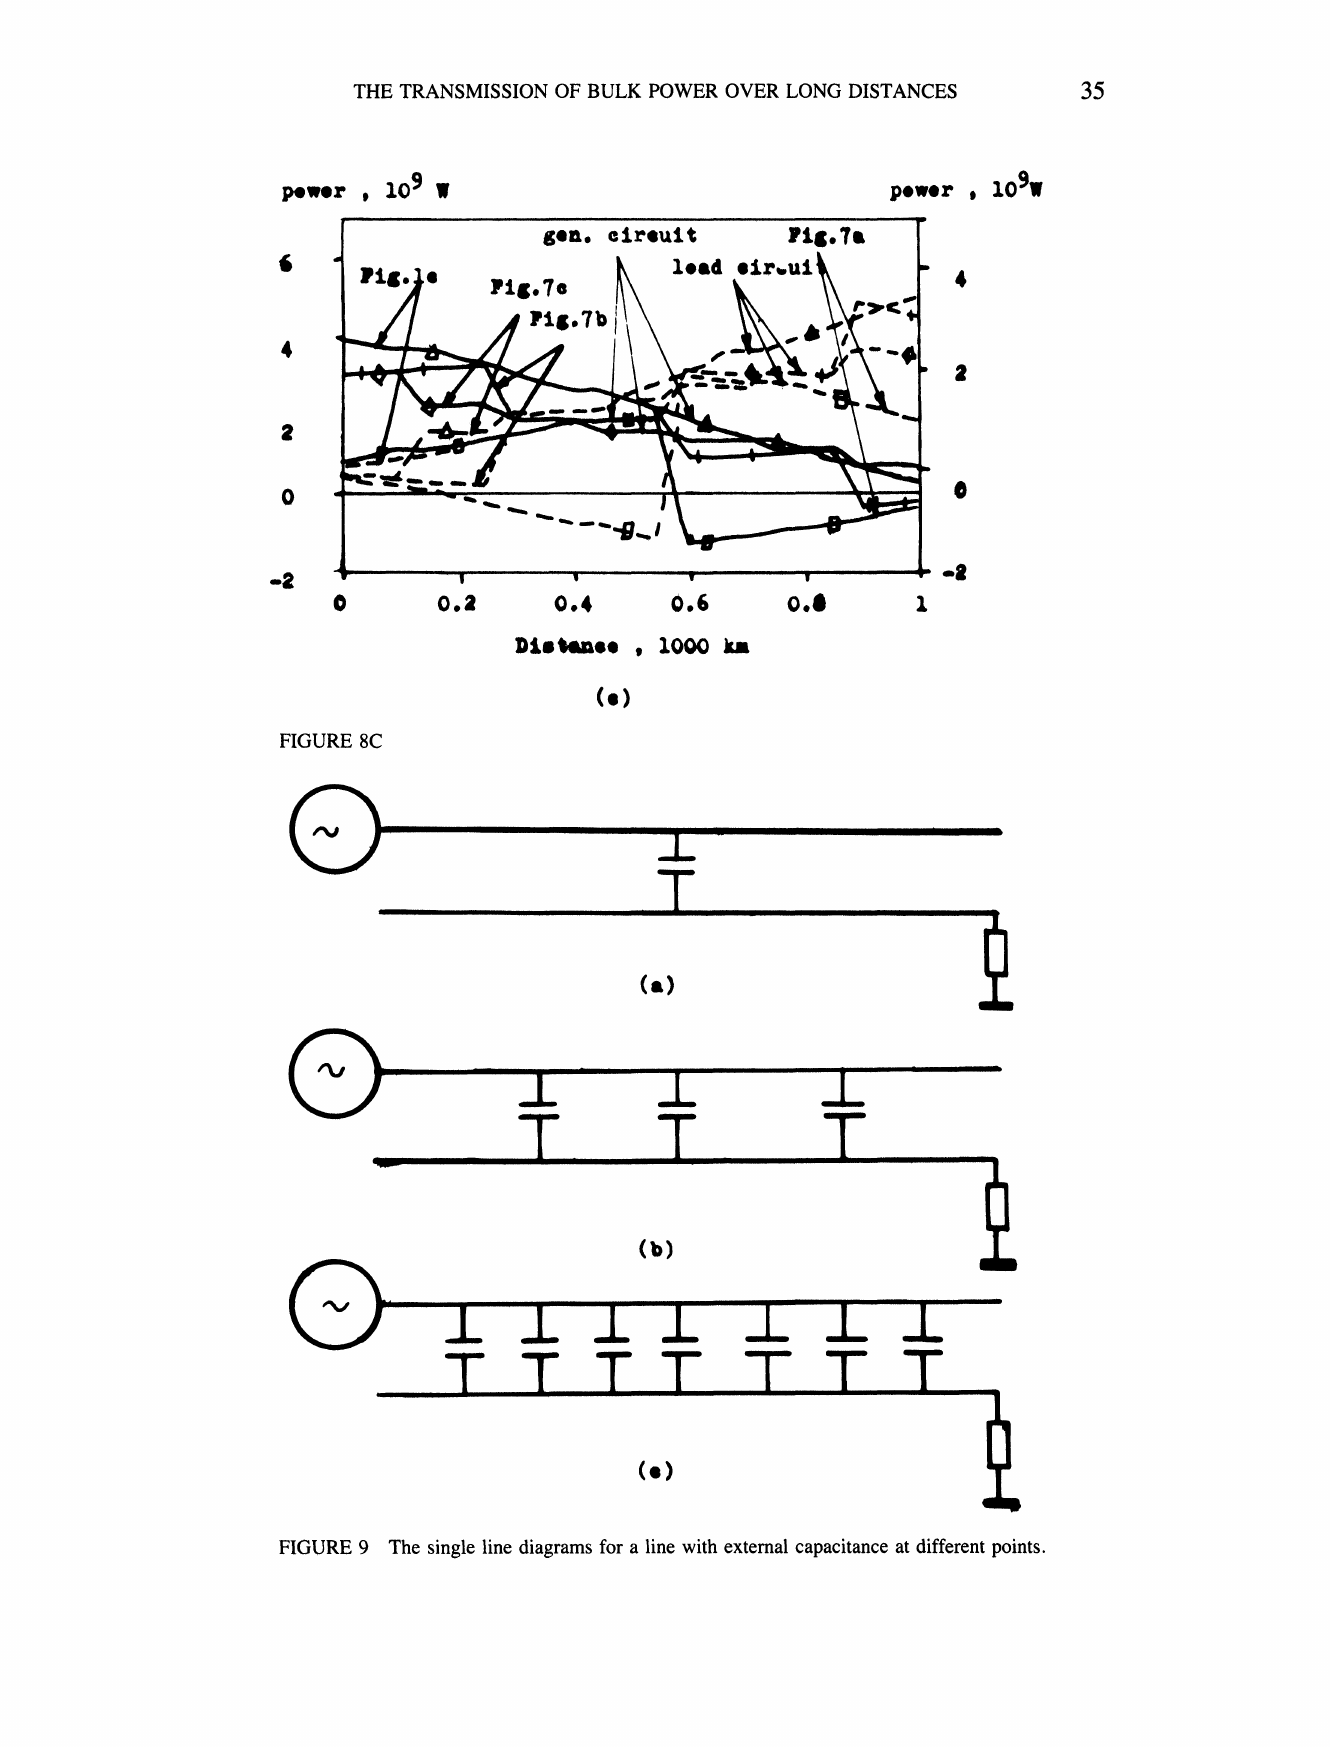
FIGURE 9 The single line diagrams for a line with external capacitance at different